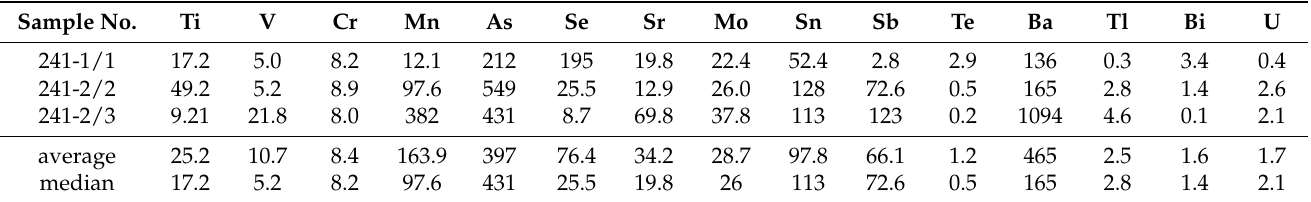
Table 9. ICP-MS-based contents of chemical elements of Zn-rich smoker chimneys from the Irinovskoe HSF